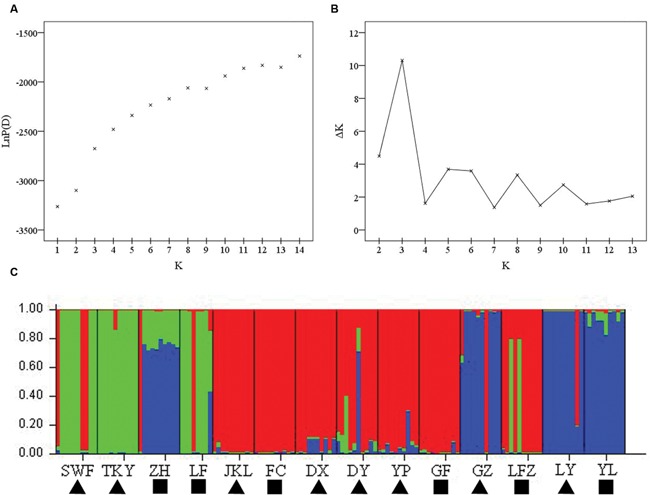
The Bayesian analysis results of C. communis based on SSR data. (A) Plot of mean posterior probability LnP(D) values of each K; (B) STRUCTRE estimation of the number of populations for K ranging 1–14 by delta K-value (ΔK); (C) the result of the assignment of individuals for K = 3. Individuals are represented as thin vertical lines partitioned into segments corresponding to the inferred genetic cluster as indicated by color and populations were marked on the bottom. The abbreviations of population name are same as Table 1.